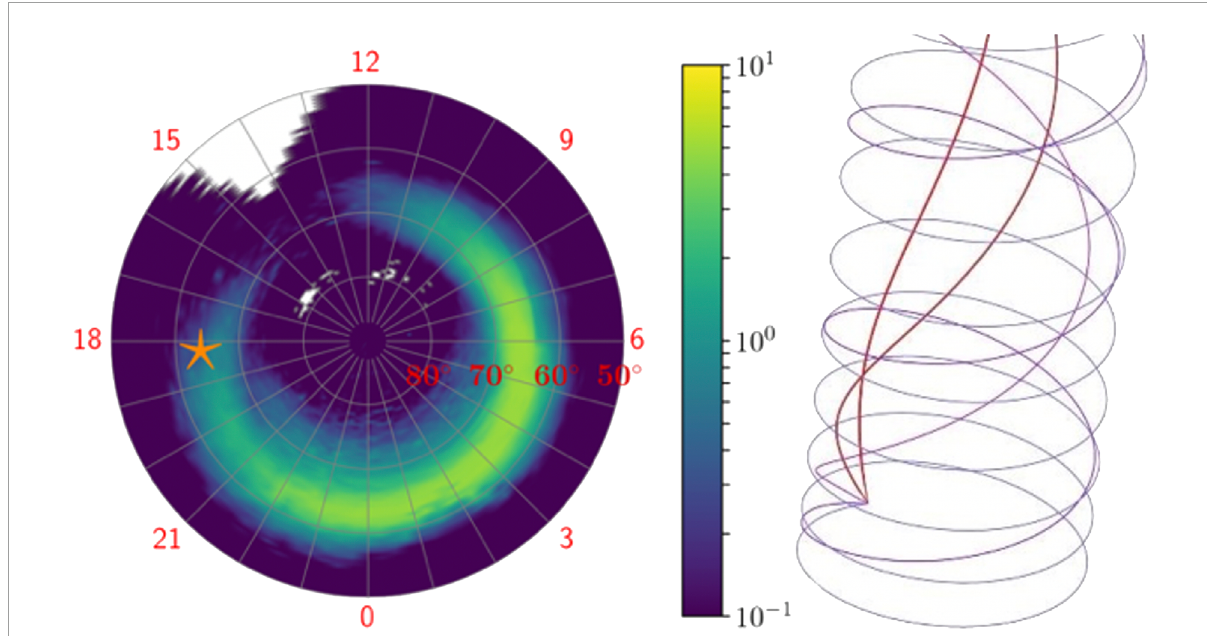
FIGURE 3 Left: Northern hemisphere diffuse auroral electron energy flux ( mW / m 2 ) based on Ovation Prime. Right: Simulation of particle gyro-motion for different pitch angles; Adapted from Sarris et al.